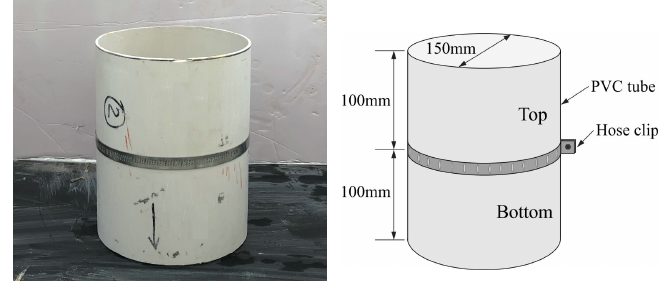
Figure 3. Segregation resistance test apparatus.